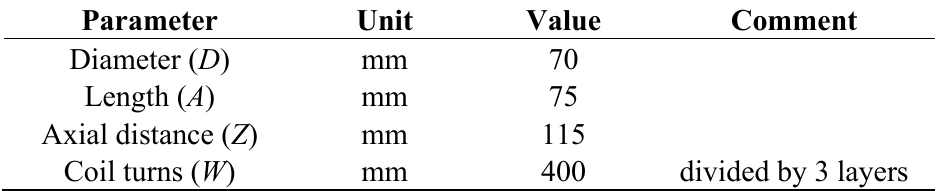
Table 1. Geometrical parameters of Solenoid I and II.